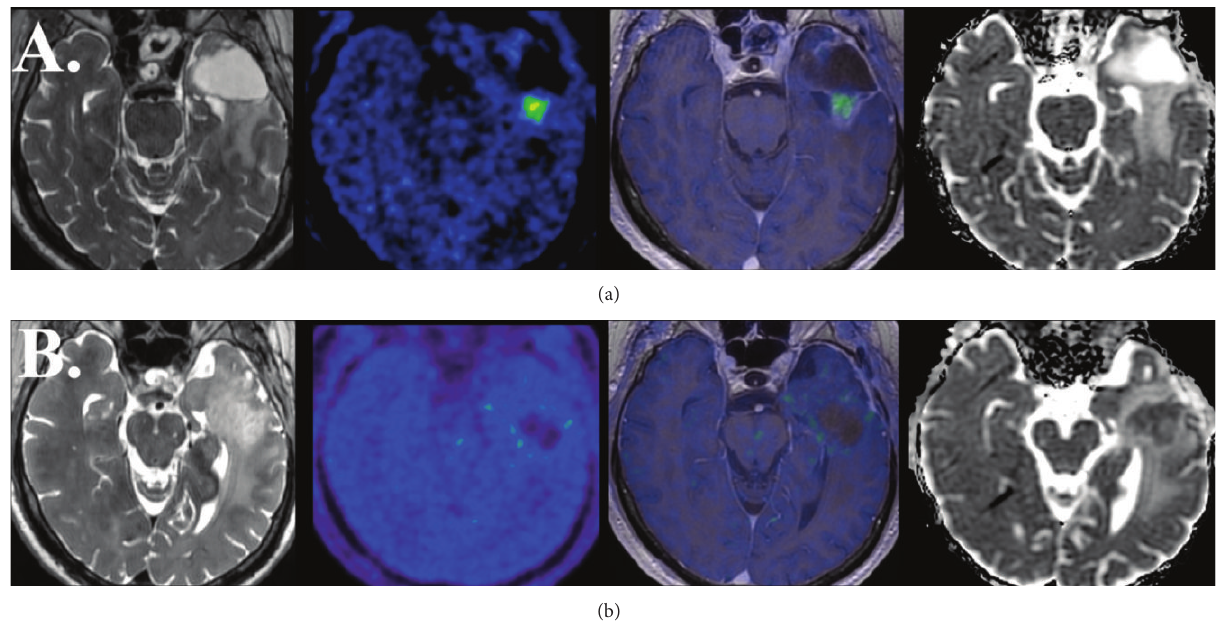
Figure 1: Single modality FMISO PET/MR imaging in a 65-year-old man with recurrent left temporal lobe WHO grade III anaplastic astrocytoma immediately prior to (a) and concurrent with bevacizumab therapy (b). Baseline, simultaneously obtained, axial T2 weighted (left), FMISO PET (middle left), fused FMISO PET and T1 weighted post contrast (middle right), and apparent diffusion coefficient (right) PET/MR imaging demonstrate recurrence of disease evidenced by contrast enhancing focus bordering the posterior margin of an anterior left temporal lobe resection cavity. This region demonstrates increased FMISO uptake with no evidence of associated reduced diffusion. Follow- up PET/MR imaging 10 weeks later (after 4 doses of bevacizumab) demonstrates the development of a nonenhancing T2 hyperintense mass about the posterior margin of the resection cavity that is associated with the development of reduced diffusion and diminished FMISO